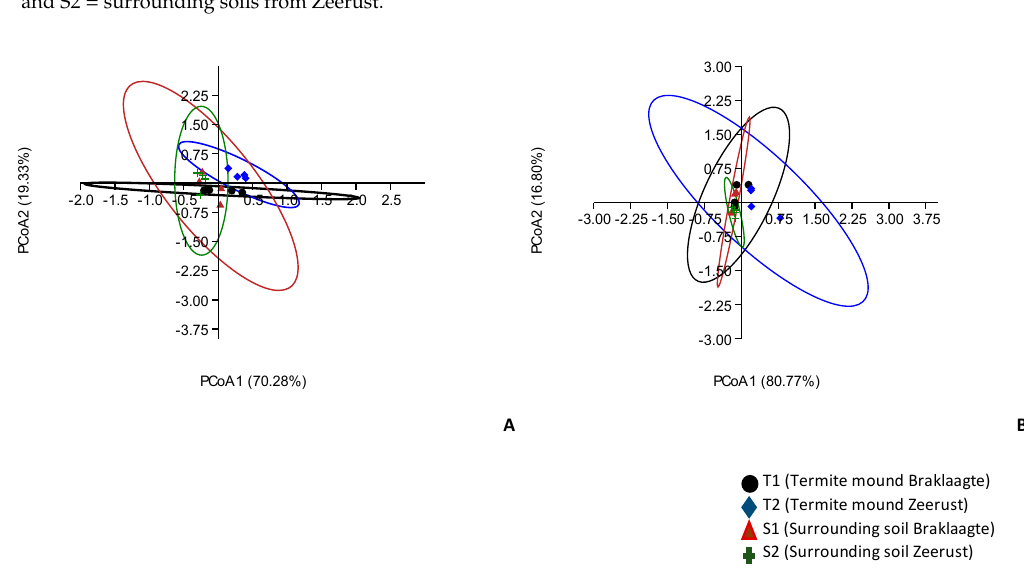
Figure 4. Principal coordinates analysis (PCoA) of ( A ) archaeal taxonomic composition and ( B ) functional categories of termite mound soils and their surrounding soils.